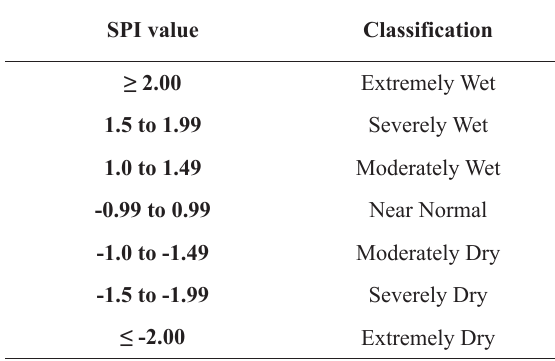
Table 2: Classification of SPI